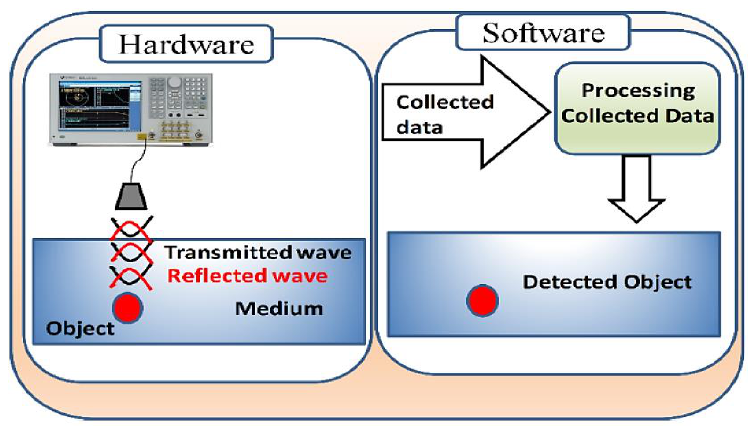
Figure 8. A schematic diagram showing the components of the microwave imaging system